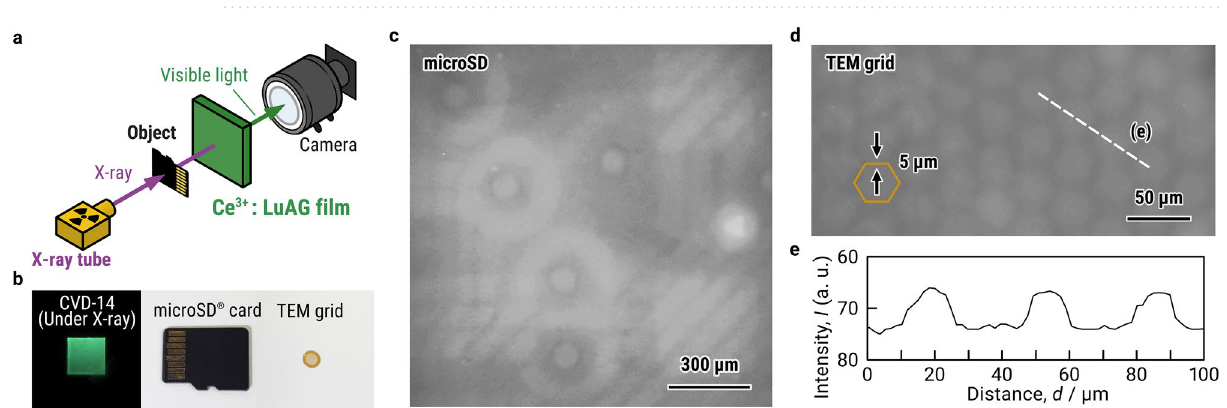
Figure 3. α-Particle-induced scintillation properties of the Ce 3+ :LuAG thick film scintillators. ( a ) α-Particle- induced decay profile of CVD-14, SC-30, and SC-1000. Solid lines indicate fitted curves of two exponential functions. ( b ) Pulse height spectra of CVD-14, SC-30, and SC-1000. ( c ) Light yield and energy resolution of the Ce 3+ :LuAG thick film scintillators (CVD-1 to CVD-25) as a function of its thickness and those of reference Ce 3+ :LuAG single crystals (SC-30, SC-1000, and ref. 15).